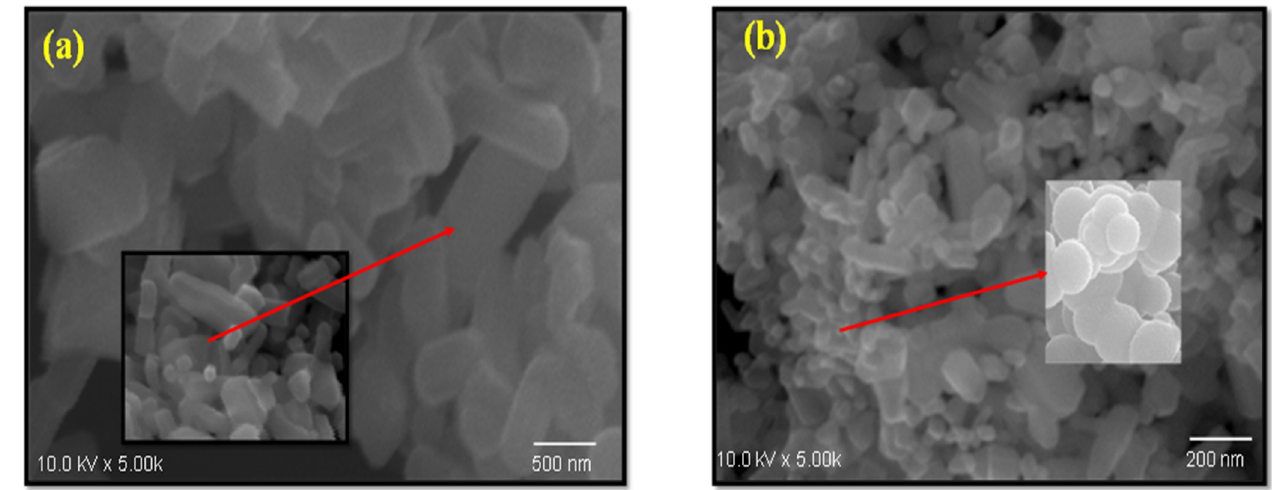
Figure 1. SEM image of ( a ) ZnO and ( b ) Ag-ZnO.